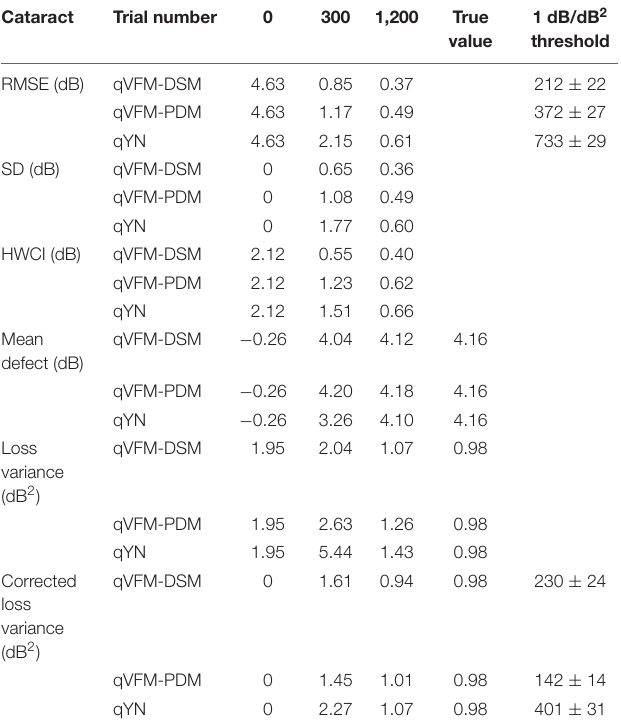
TABLE 5 | RMSE, SD, average 68.2% HWCI, mean defect, loss variance and corrected loss variance of the estimated VFM from the qVFM-DSM, qVFM-PDM and qYN methods in the beginning (0 trial), after 300 and 1,200 trials are listed for the simulated cataract observer.